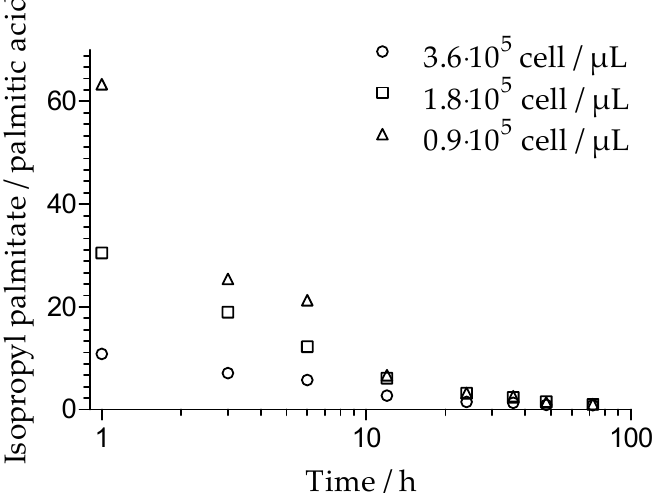
Figure 2. The hydrolysis of isopropyl palmitate over time, expressed as the ratio of isopropyl palmitate to palmitic acid (mg/mg) after incubation with M. sympodialis with cell concentrations of 3.6 × 10 5 cell/µL, 1.8 × 10 5 cell/µL, and 0.9 × 10 5 cell/µL.